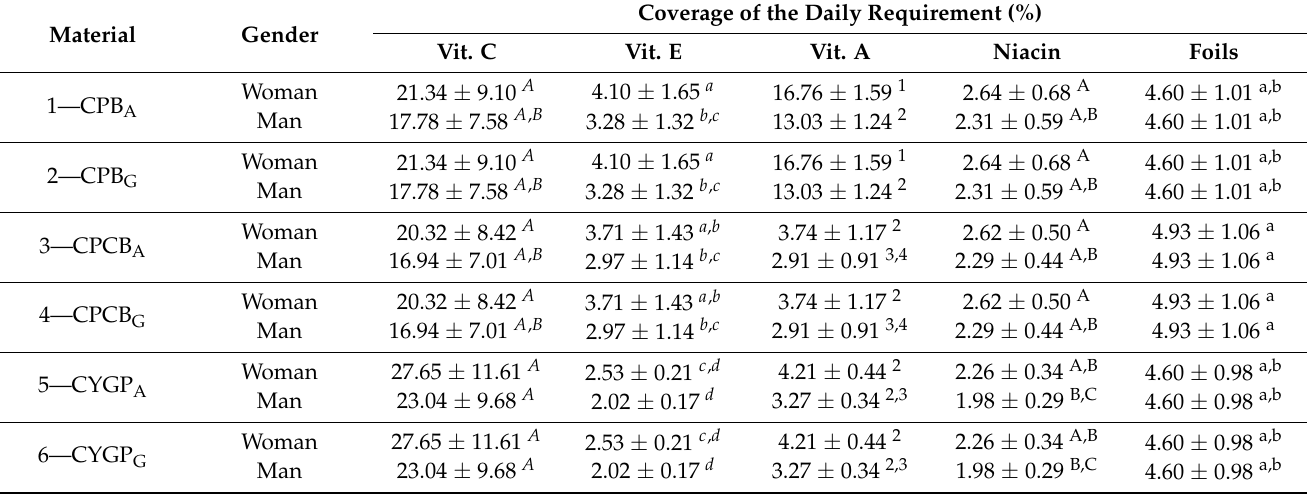
Table 5. Average coverage of the daily requirement (CDR) for selected vitamins in the human diet by freeze-dried products based on vegetables produced with hydrocolloids (10 g).